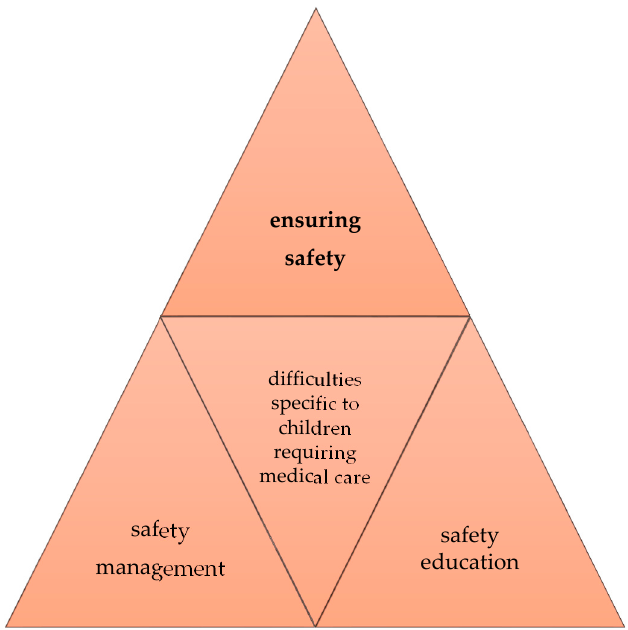
Figure 3. Safety assurance measures for children, including those requiring medical care, in general schools.